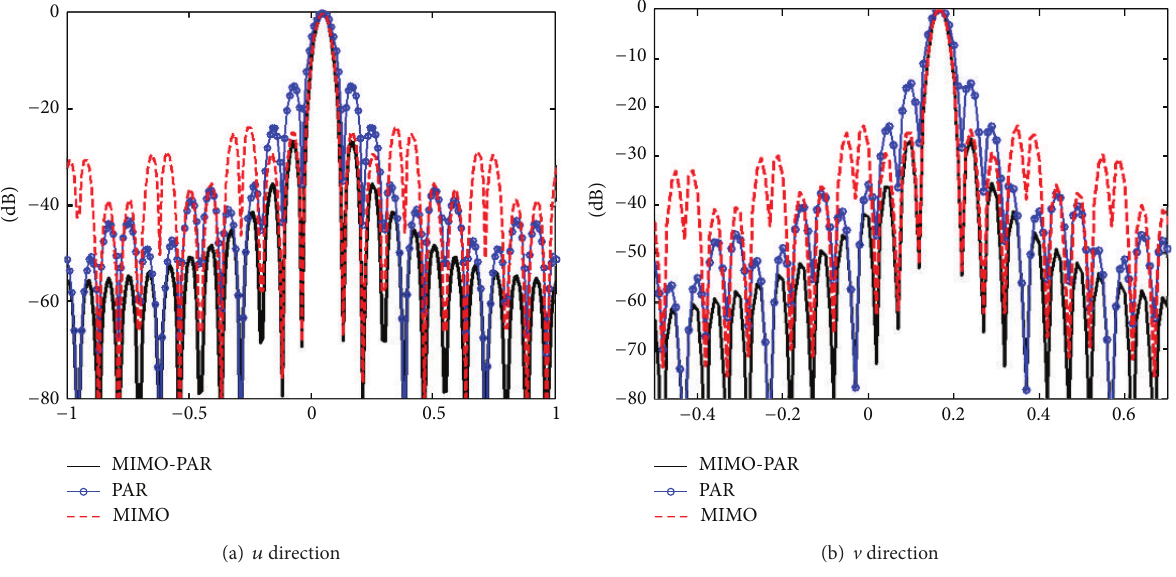
Figure 20: Total patterns of PAR, MIMO, and